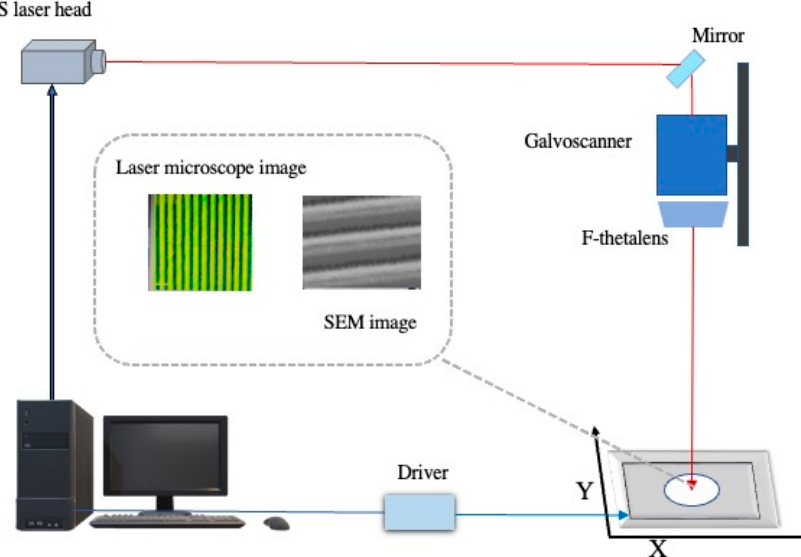
Figure 1. Schematic diagram of the femtosecond laser processing system.